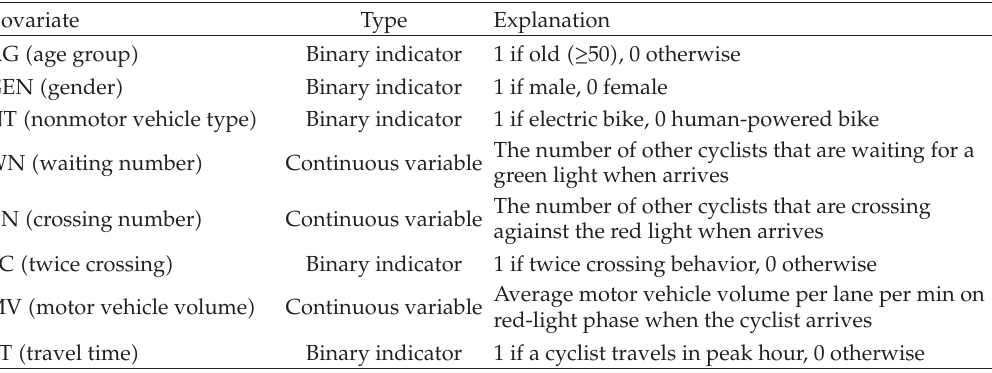
Table 1: Covariates selection and